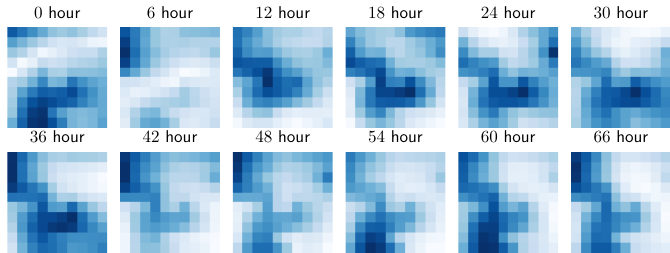
Figure 11. The first 72 h of wind speeds used from the Copernicus